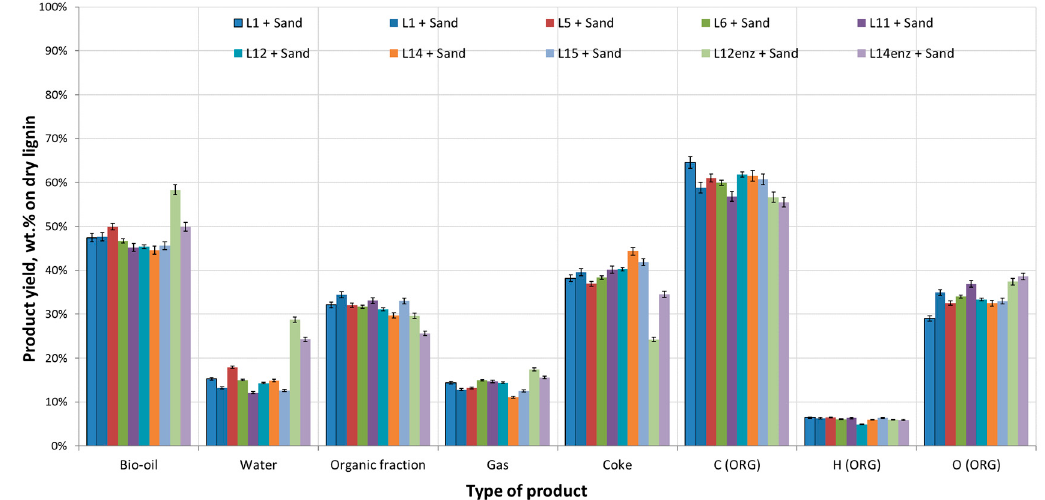
Figure 1. Product yields and bio-oils elemental analysis (dry basis) from thermal pyrolysis of organosolv-derived beechwood lignins.